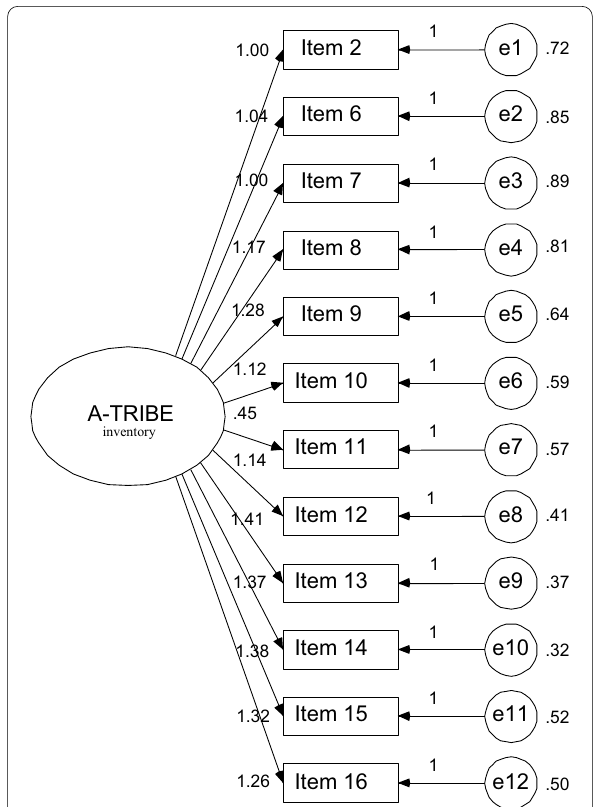
Fig. 1 CFA single‑factor model testing on the 12 final items of the A‑TRIBE inventory (unstandardised loadings)